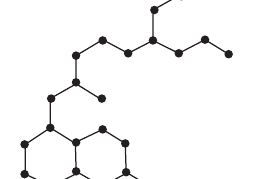
Figure 9: Molecular graph of